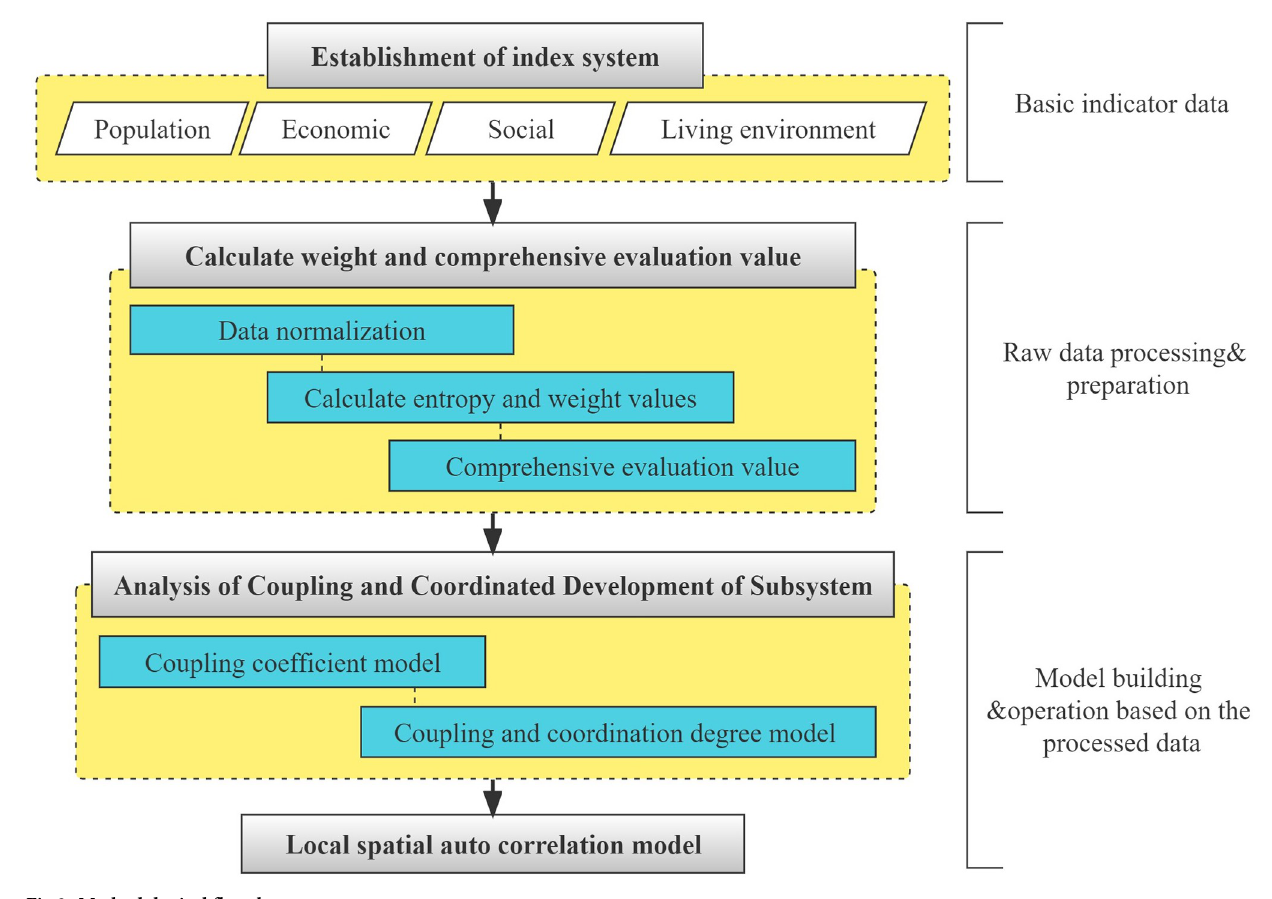
Fig 2. Methodological